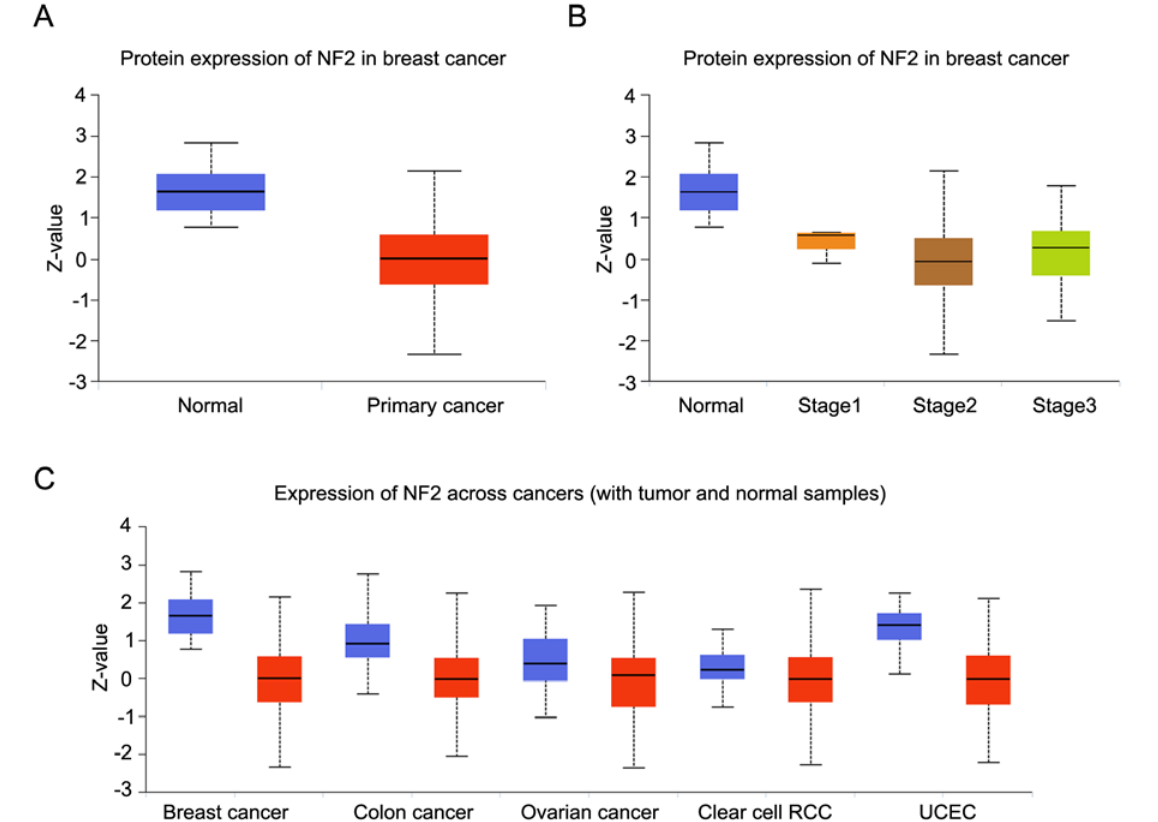
Figure 1: A Protein expression of NF2 in breast cancer. B Protein expression of NF2 in breast cancer based on individual cancer stages. C Pan- cancer view of NF2 expression